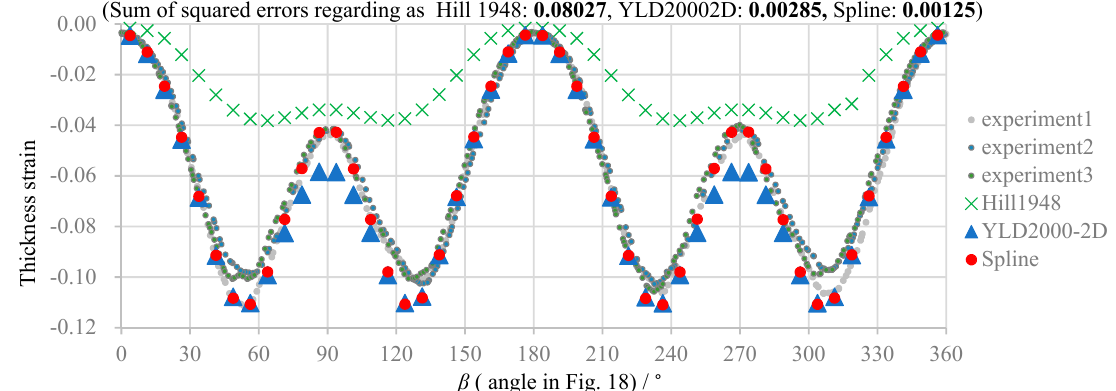
Figure 22. Comparison of thickness strain distributions on circle 1 in experimental condition B.